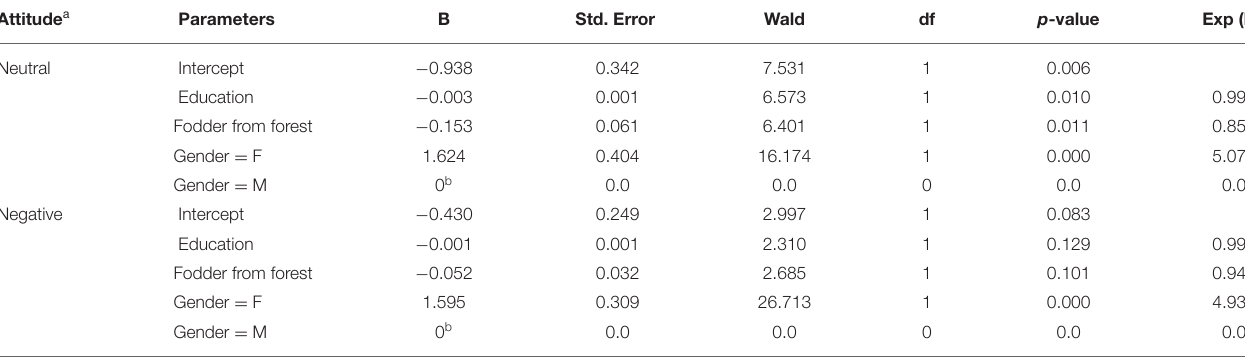
TABLE 5 | Multinomial logistic regression model explaining the attitude of people towards tiger in Sariska Tiger Reserve: parameter estimates. Attitude